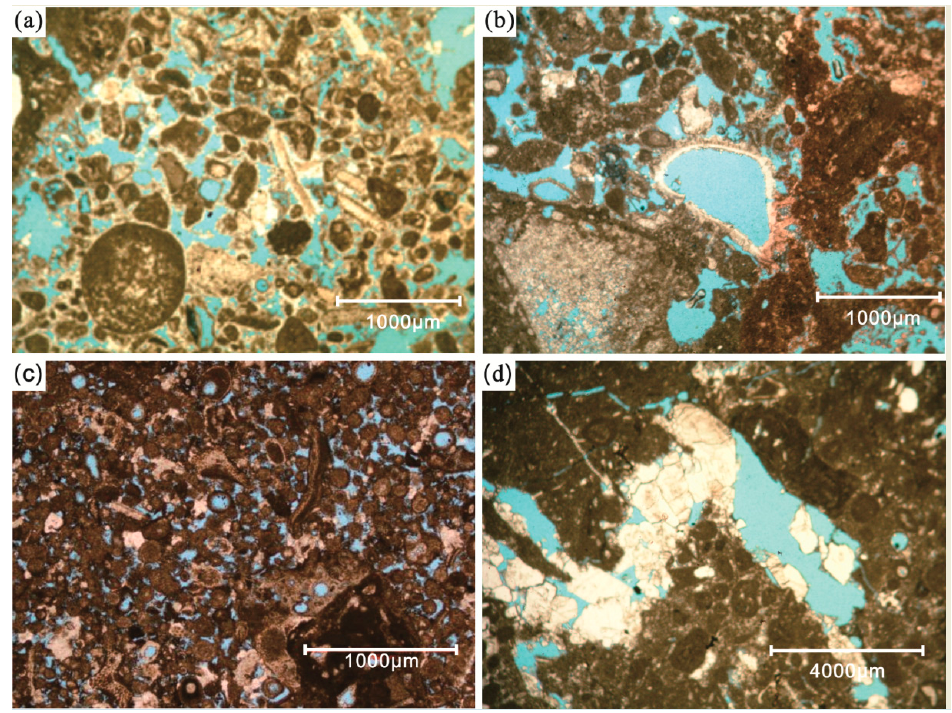
Figure 10. Types of reservoir space in the fore ramp of Callovian-Oxfordian Stage. ( a ) Intraclastic bioclastic grainstone, with residual primary intergranular pores, intergranular dissolved pores, intragranular dissolved pores and mold pores, XVa1, 3158.61 m, Well Pir-21, front ramp bioclastic shoal, casting thin section (-); ( b ) Intraclastic bioclastic grainstone, with intergranular dissolved pores, intragranular dissolved pores and molded pores, XVa1, 3158.6 m, Well Pir-21, front ramp bioclastic shoal, casting thin section (-); ( c ) Ooidal grainstone, with residual primary intergranular pores, intergranular dissolved pores, intragranular pores and mold pores, XVm, 3791.0 m, Well Oja-21, front ramp ooidal shoal, casting thin section (-); ( d ) Lump packstone, with framework dissolved pores and dissolved fractures, XVa1, 3552.17 m, Well Cha-21, front ramp mound, casting thin section